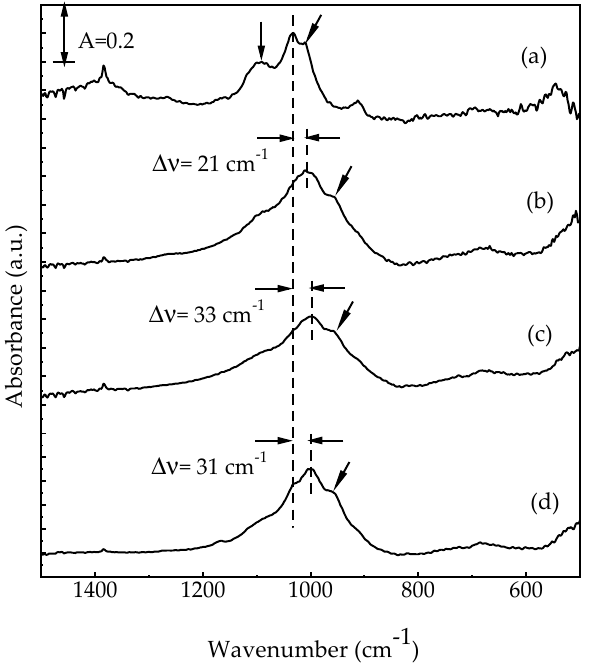
Figure 3. Fourier-transform infrared spectra of ( a ) humic acid, ( b ) simulated sorbent for soil remediation, and Cr–contamined simulated sorbent for soil remediation ( c ) before and ( d ) after extraction with [C 4 mim]Cl.